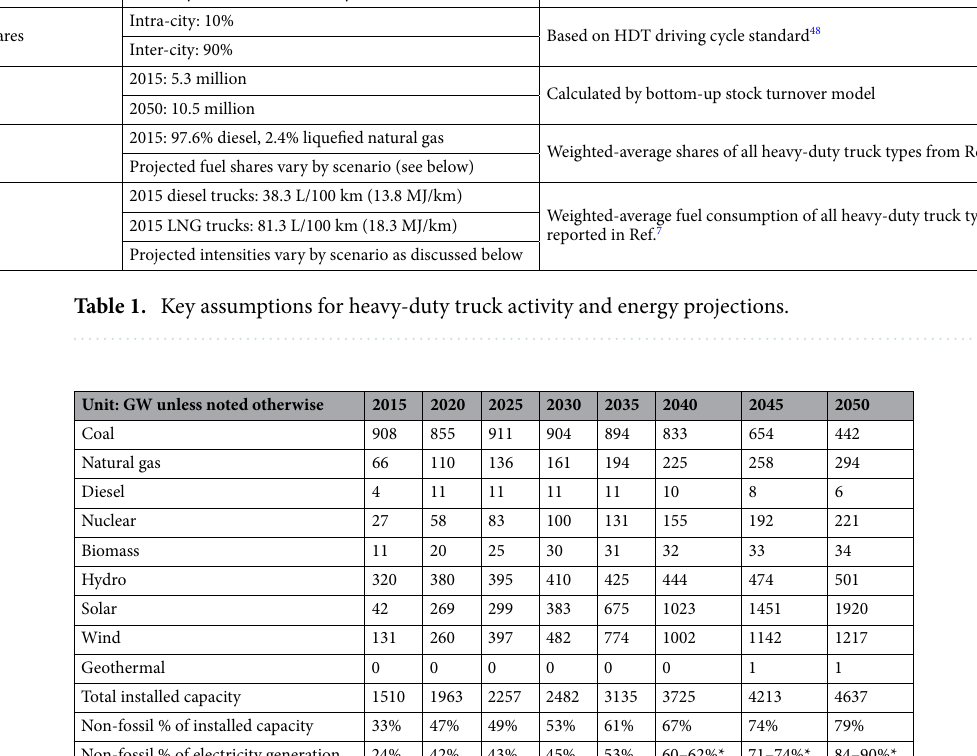
Table 2. Key installed capacity assumptions for power sector. *Non-fossil % of electricity generation varies by HDT scenario described below.